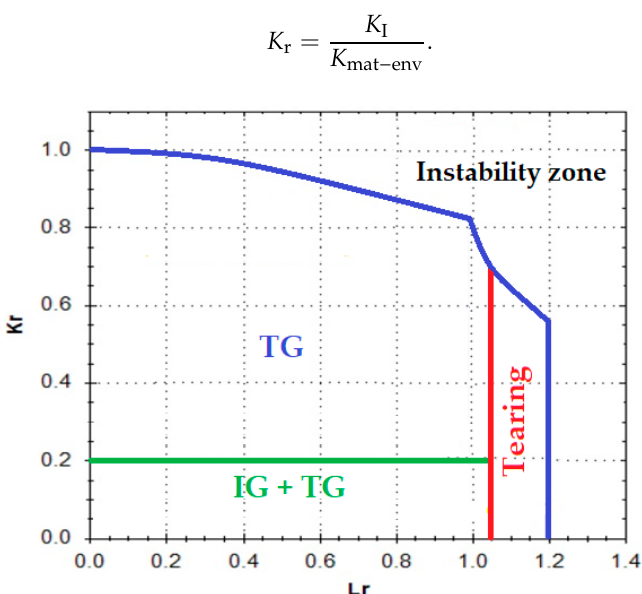
9 of 19 Figure 8. Schema of cathodic protection (left) and cathodic polarization (right) set-ups. 3.3. Optimization Proposals for the Model Presented in Epigraph 2 In the present work, an optimization of the model exposed in [5] (epigraph 2) is presented. It consists of the improvement of the following aspects: